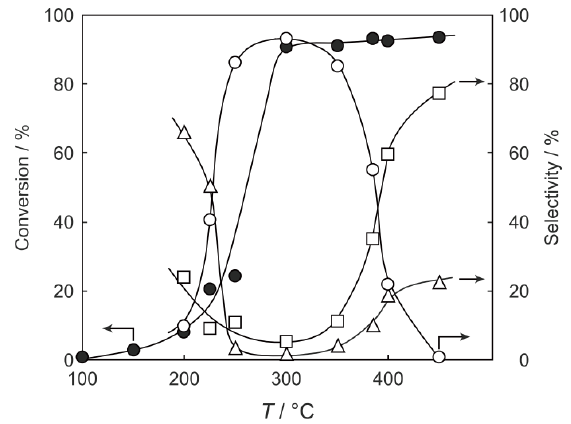
Figure 28. Effect of temperature on the reaction of cyclohexanone oxime over (H O) [(W Cl )Cl ]·6H O/SiO in a helium stream. Supported cluster (10 mg, 0.29 μmol) 3 2 6 8 6 2 2 were activated in a helium stream (1.2 L/h) for 1 h, and a methanol solution of cyclohexanone oxime (17 mol%, 200 μL/h, 0.65 mmol/h) was introduced into the helium stream without changing the temperature. Conversion of cyclohexanone oxime (●); selectivity for ε-caprolactam (○); selectivity for cyclohexanone and 2-cyclohexen-1-one (∆); and selectivity for decomposition products including hexanenitrile and hex-5-enenitrile (□); at 3 h after the start of the